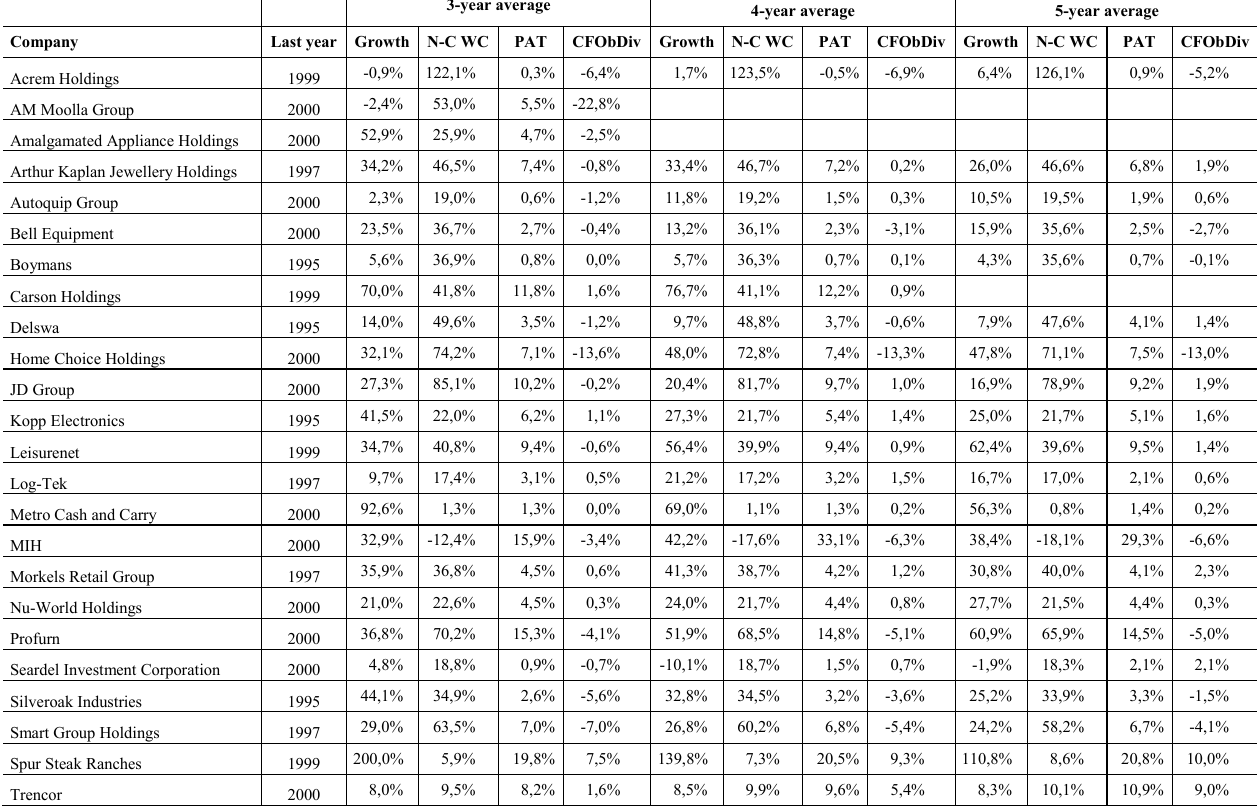
Table 5: Ratios per company